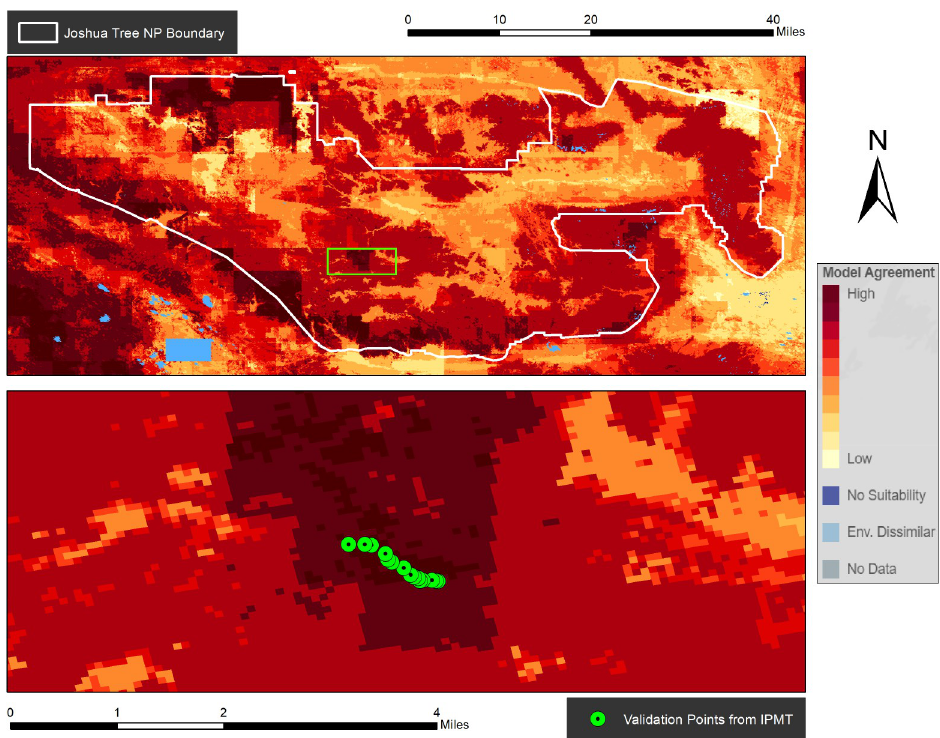
Fig 4. Maps of fountain grass habitat suitability within Joshua Tree National Park. The top map displays the full park extent while the bottom inset map displays the independently surveyed validation points (not included in the Invasive Species Habitat Tool [INHABIT] models) provided by the National Park